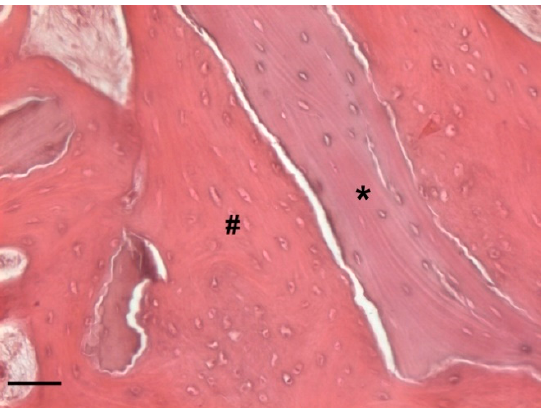
Figure 16. Detail of the bone sample stained with Hematoxylin and Eosin staining solution (magnification 100×, scale bar 100 µm). Graft material appears light-pink colored and with empty lacunae (*). The residual graft material appears detached from the bone surface due to a cutting artifact. Indeed, the bone graft particles appear to be completely osteointegrated and surrounded by woven bone (#). Big lacunae containing immature osteocytes are visible.